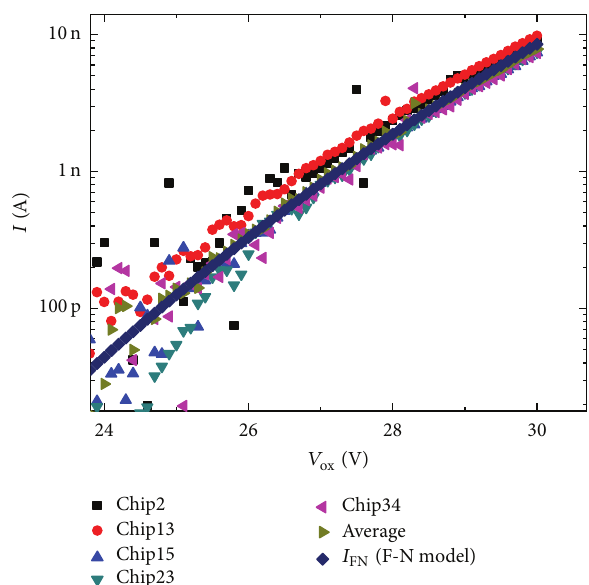
Figure 5: Five structures with F-N tunneling current, average curve, and F-N model using technological parameters.